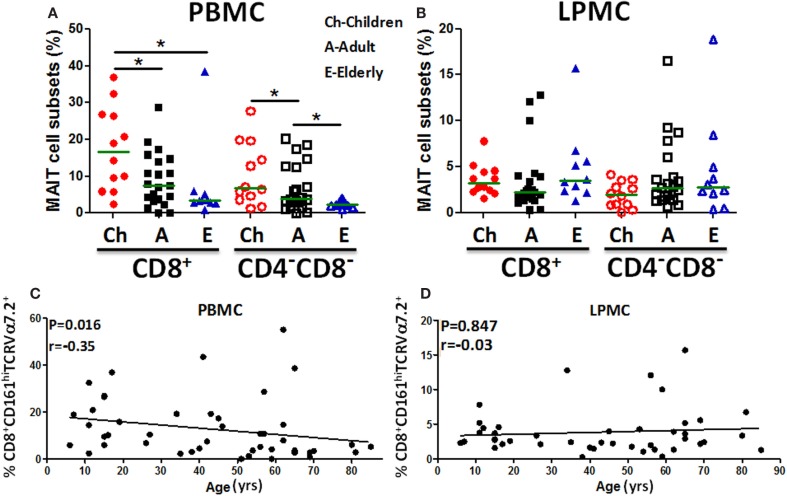
MAIT cells in blood (PBMC) and gastric LPMC in children, adults, and the elderly. (A) PBMC and (B) gastric LPMC obtained from children (n = 12), adults (n = 21), and the elderly (n = 10) were evaluated for the presence of MAIT cells. Significant differences among age groups are denoted by asterisks (*P < 0.05). (C) Correlation of CD8+ MAIT cells with age in PBMC (n = 46) and (D) in gastric LPMC (n = 43) was performed using Spearman’s correlation analysis. Horizontal green lines in (A,B) represent medians.